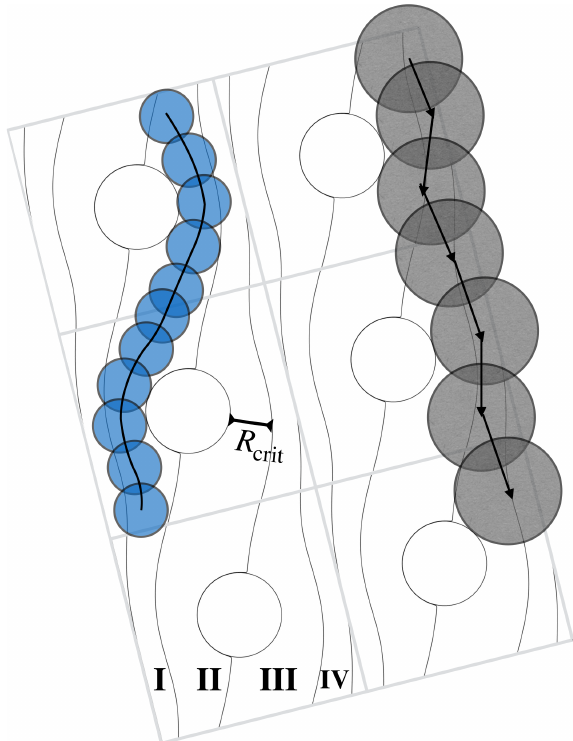
Figure 2. Geometry of the unperturbed Stokes flow through the periodic lattice for a lattice angle θ l = tan − 1 ( 1/4 ) . The flow through the elementary periodic cell is divided into four flux tubes (labelled as “I”, “II”,“III”,“IV”), which are identified by critical streamlines that depart from and terminate onto, the obstacle boundaries. The width, R crit , of the flux tube next to the obstacle boundary defines the critical particle radius separating “zig-zag” and displaced transport